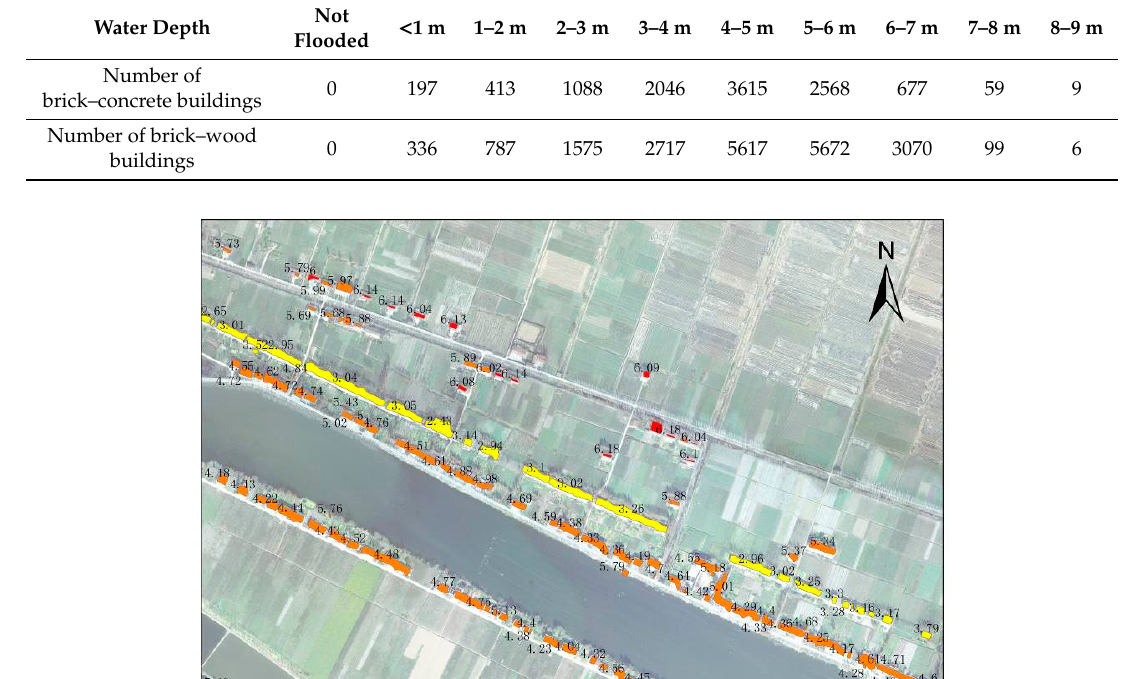
Table 3. Flood statistics for brick–concrete and brick–wood buildings.